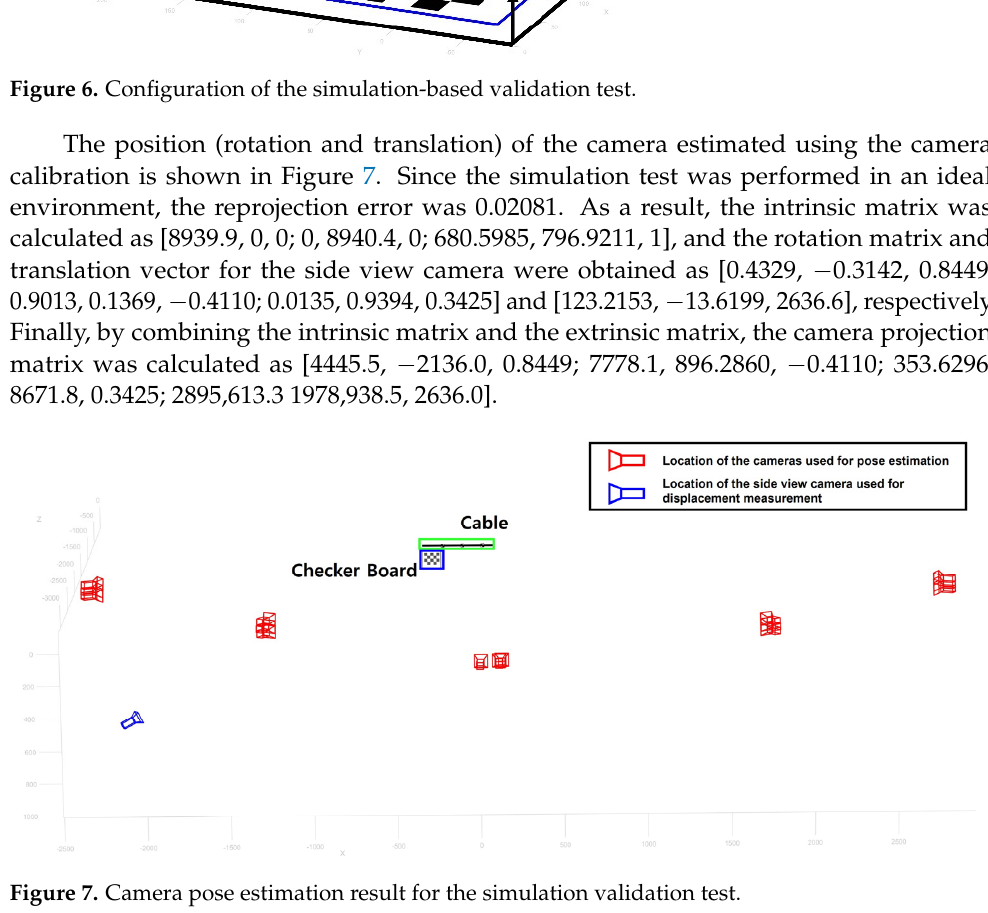
Figure 7. Camera pose estimation result for the simulation validation test.